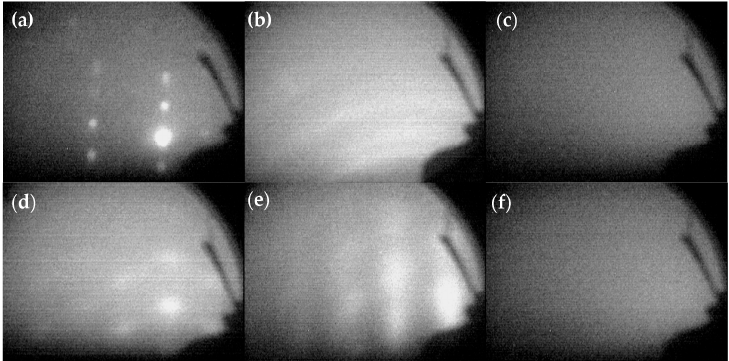
Figure 2. RHEED (reflected high energy electron diffraction) patterns of ( a ) a LGS substrate, ( b ) ZnO directly deposited on LGS. RHEED patterns have also been obtained for ( c ) an Al 2 O 3 barrier layer, ( d ) ZnO, ( e ) Pt, and ( f ) the Al 2 O 3 protective layer during the process of depositing the Al 2 O 3 /Pt/ZnO/Al 2 O 3 electrode.